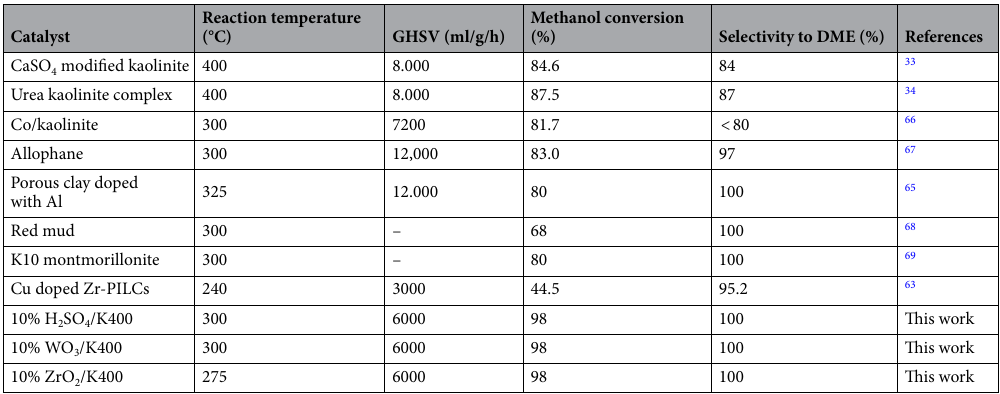
Table 3. Comparison of the activity of the most active catalysts with that published in the